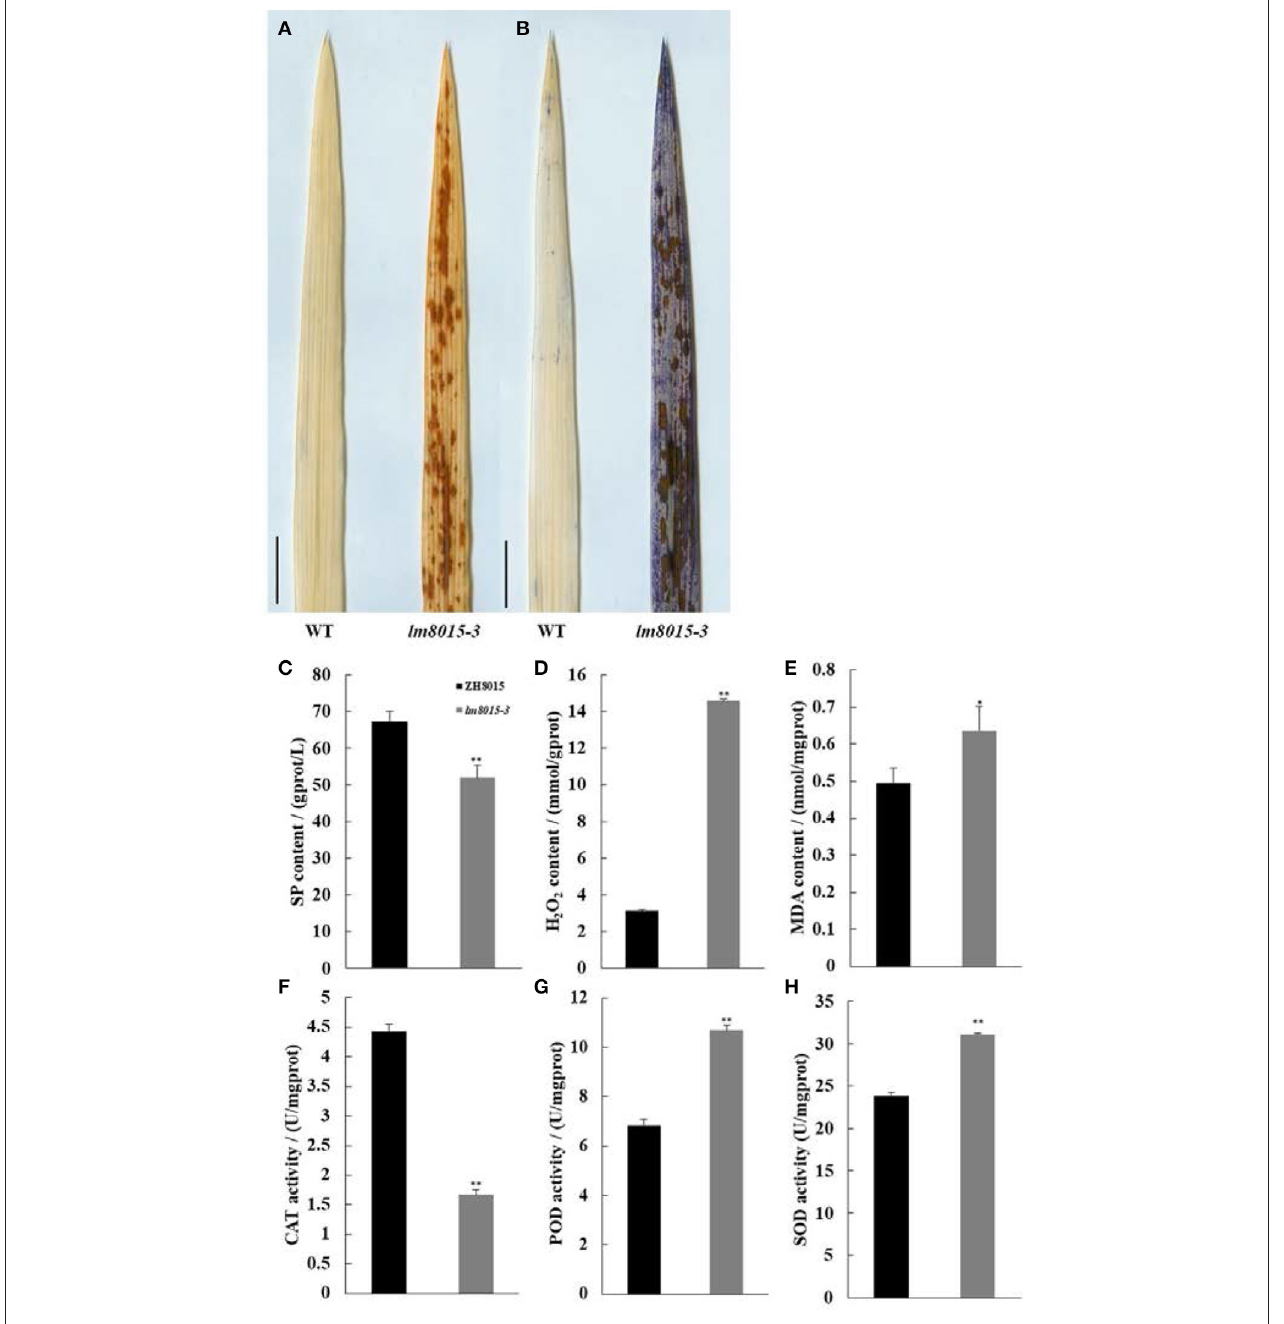
FIGURE 3 | Staining and physiological indices of ZH8015 and lm8015-3. (A,B) DAB staining and EB staining of the leaves of the wild type (ZH8015) and lm8015-3 at the tillering stage. Scale bar = 2cm. (C–H) Measurements of SP content, H 2 O 2 content, MDA content, CAT activity, POD activity, and SOD activity of ZH8015 and lm8015-3 at the tillering stage. *Significant at P < 0.05 ( t -test); **Significant at P < 0.01 ( t -test); Error bars represent SD ( n = 3).